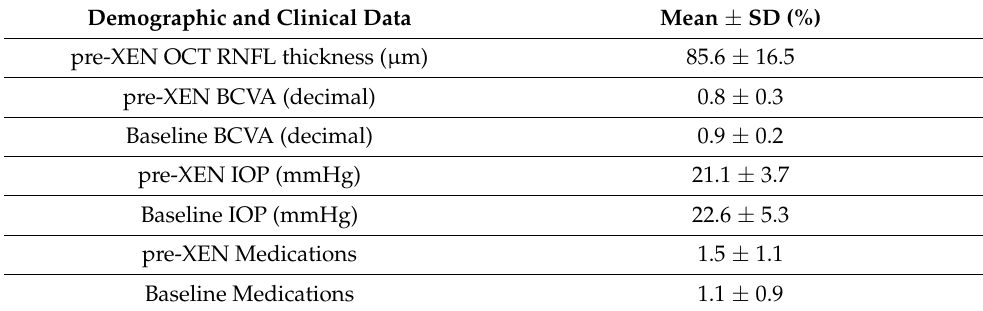
Table 1. Cont. Demographic and Clinical Data